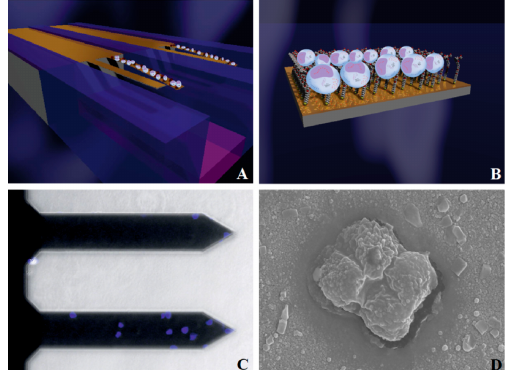
Figure 12. Nanomechanical detection of cancer cells in a model of breast cancer. ( A ) Schematic diagram showing the attachment of malignant cells to the cantilever surface; ( B ) close-up image of the cell–receptor complex on the nanomechanical cantilever surface; ( C ) attachment of stained MDA-MB231 breast cancer cells (blue) on the working microbeam and the reference microbeam; ( D ) SEM of a cancer cell attached to the measuring nanomechanical cantilever sensor [151].